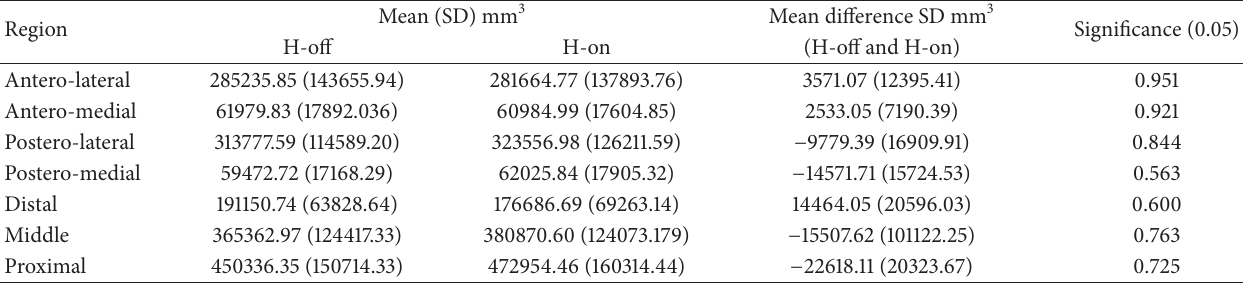
Table 5: Mean and standard deviation of regional volume for Hands-on, Hands-off casting concepts and inter cast volume difference, significance of inter cast regional volume difference, 𝑡